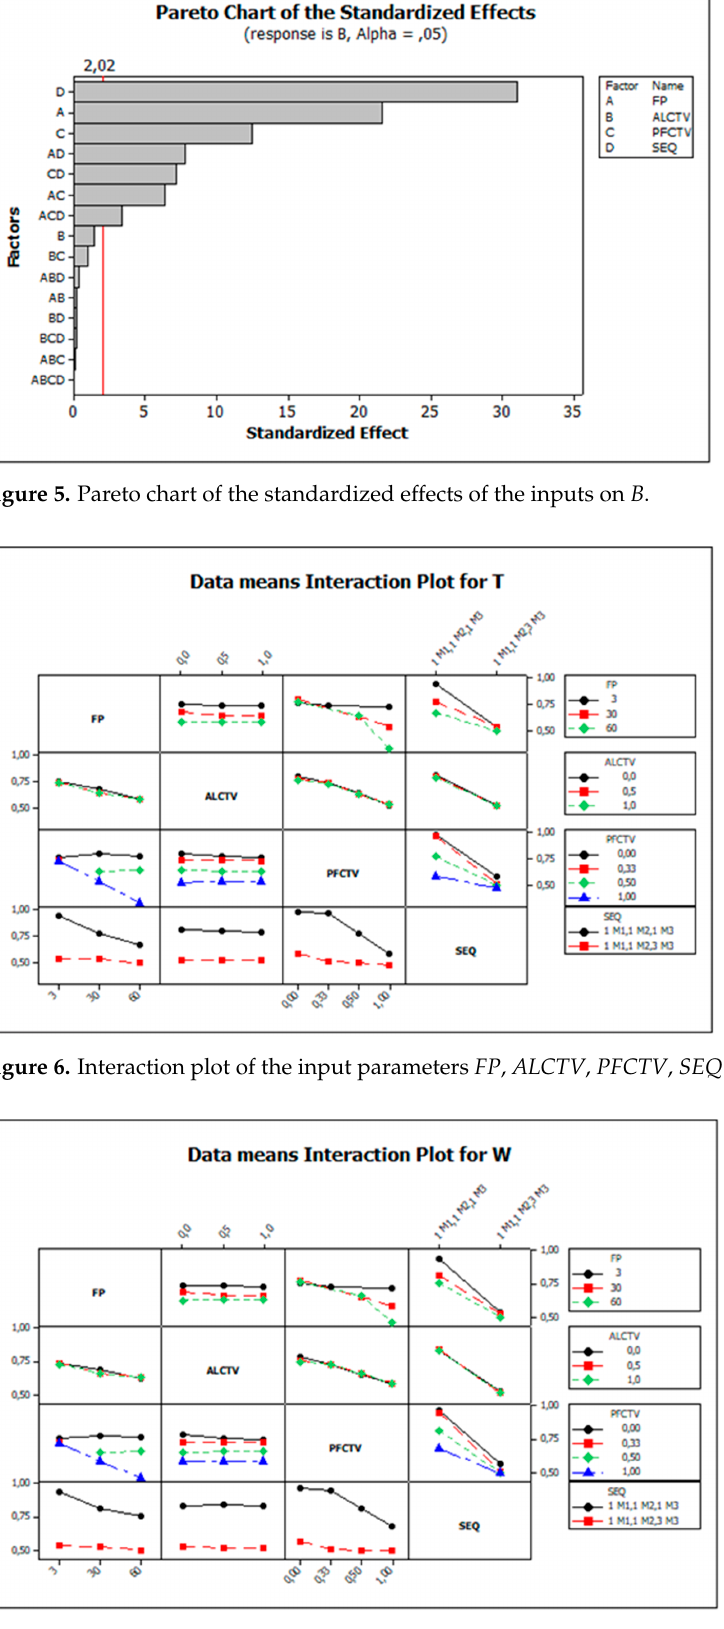
Figure 4. Pareto chart of the standardized effects of the inputs on W.